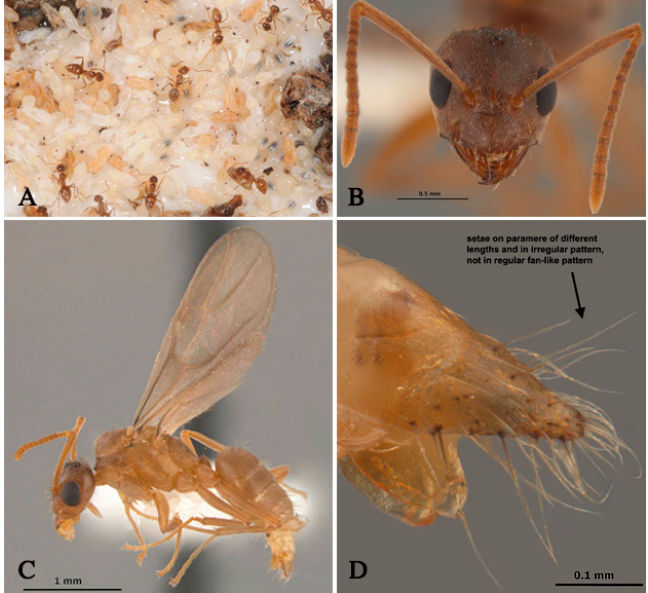
Figure 1. ( A ) Nylanderia fulva workers with brood; ( B ) Full face view of N. fulva female; ( C ) Lateral view of N. fulva male; ( D ) Lateral view of N. fulva male paramere. Picture A was taken by Blake Layton